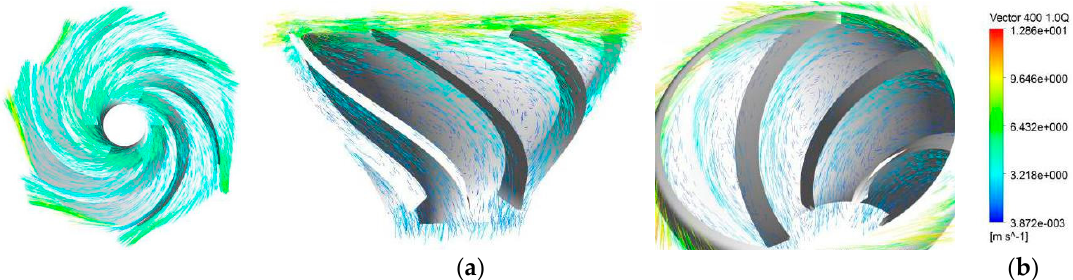
Figure 9. Speed vector at 400 °C design conditions. ( a ) Impeller speed vector. ( b ) Vane diffuser speed vector.